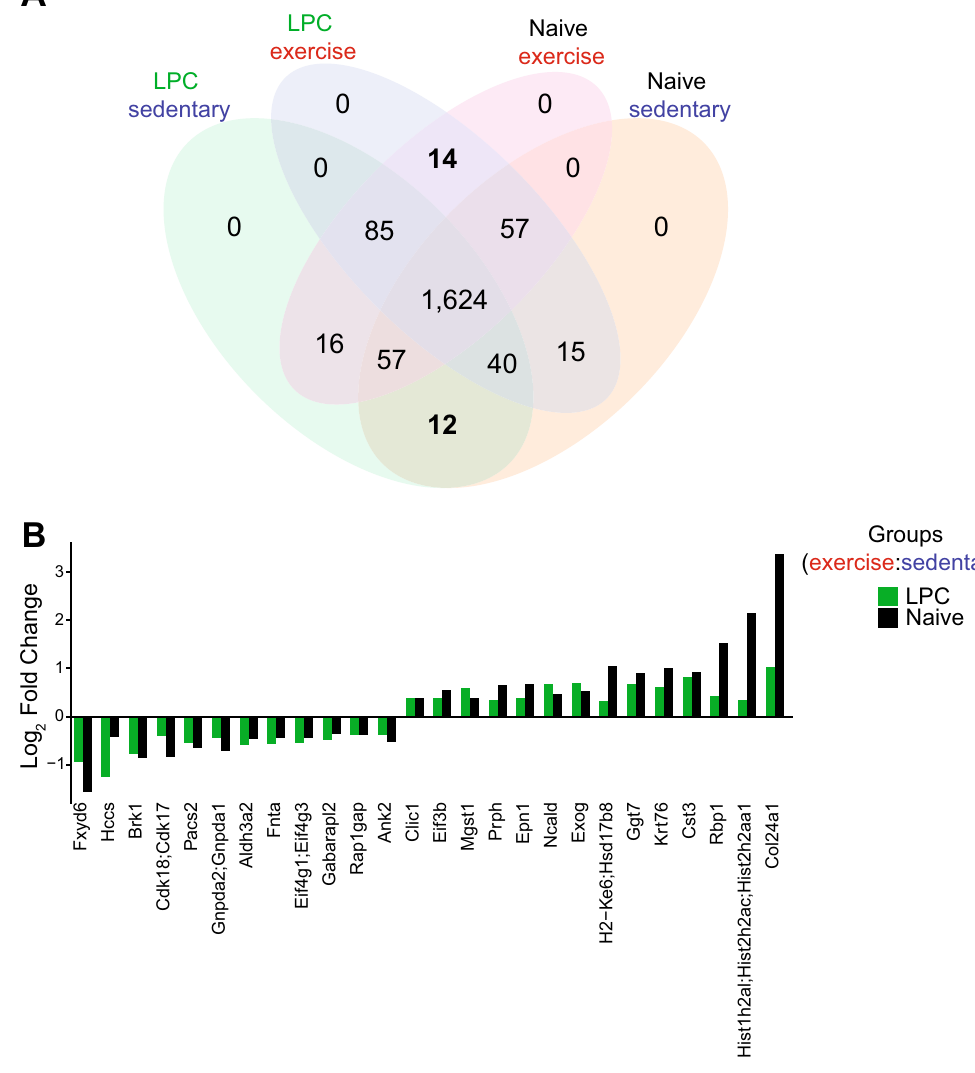
Figure 6. Comparison of shared proteins from the naïve and LPC of sedentary and exercising spinal cord proteome. ( A ) Venn diagram of enriched proteins in each of the 4 experimental groups after boxplot analysis. A total of 1624 proteins were not statistically enriched in any of the groups. 14 common upregulated and 12 common downregulated proteins between naïve and LPC exercising animals are shown in bold. ( B ) Bar plot showing the 14 proteins upregulated and the 12 proteins downregulated in both the naïve and LPC mice. Data analysis was accomplished using the R software 32 . The plot was generated using the heatmap.2 function from the gplots package 34